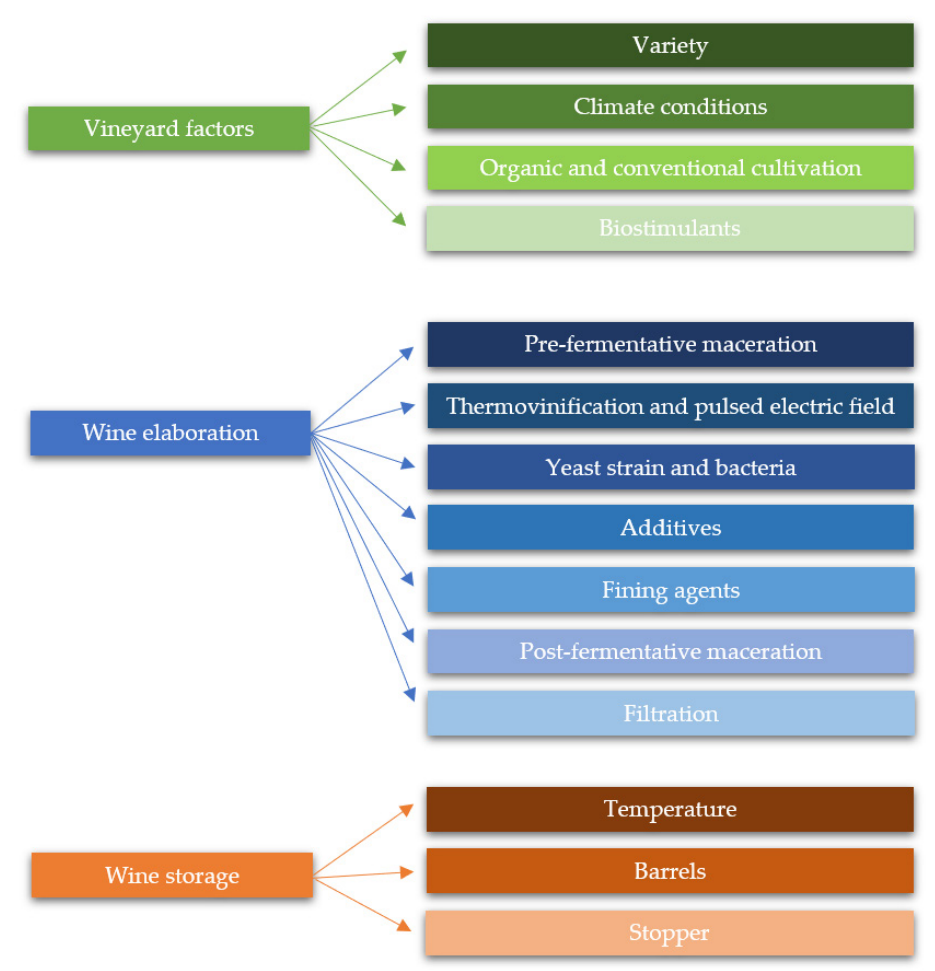
Figure 2. Summary diagram about the external factors selected to be studied and their influence on phenolic compounds in grape, must, and wine.